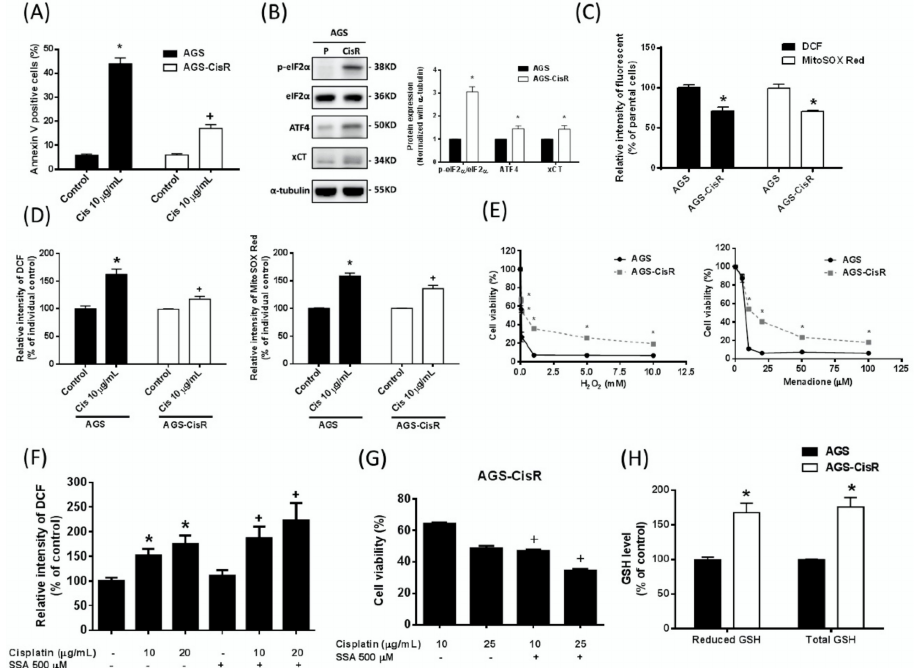
Figure 6. High expression of xCT contributes to cisplatin resistance in gastric cancer cells. ( A ) The chemoresistance in the cisplatin-resistant gastric cancer cells was further validated by the apoptosis assay. The AGS and AGS–CisR gastric cancer cells were seeded at a density of 2 × 10 5 cells per well in six-well plates and were cultured with cisplatin (Cis) for 48 h. ( B ) The integrated stress response eIF2 α –ATF4–xCT pathway between the parental and the cisplatin-resistant gastric cancer cells was evaluated by eIF2 α phosphorylation and by ATF4 and xCT induction. The immunoblot values were normalized to α -tubulin. ( C ) The AGS and AGS–CisR gastric cancer cells were seeded at a density of 3 × 10 5 cells per well in six-well plates and were cultured overnight before the determination of the basal cellular ROS level and the mitochondrial ROS level. ( D ) The AGS and AGS–CisR cells were seeded at a density of 2 × 10 5 cells per well in six-well plates and were cultured with cisplatin (Cis) for 24 h. The cellular ROS level and mitochondrial ROS level were determined by flow cytometry with DCF and MitoSOX Red staining, respectively. ( E ) The AGS and AGS–CisR cells were treated with hydrogen peroxide (H 2 O 2 ) and menadione for 48 h. The cell viability was determined by the SRB assay. ( F ) The AGS–CisR cells were seeded at a density of 2 × 10 5 cells per well in six-well plates and were cultured with cisplatin and/or sulfasalazine (SSA) for 24 h. The cellular ROS level was determined by flow cytometry with DCF staining. ( G ) The AGS–CisR cells were treated with 500 µ M SSA and cisplatin for 48 h. The cell viability was determined by the SRB assay. ( H ) The AGS and AGS-CisR cells were seeded in a 6-cm dish at a density of 3 × 10 5 cells and were cultured overnight prior to determination. The total/reduced GSH levels were analysed by the GSH assay kit. Data represent the mean ± SEM of three independent experiments. * p < 0.05, compared with the parental cells or control group; + p < 0.05, compared with the cisplatin-treated AGS parental cells or individual non-SSA cotreated AGS–CisR